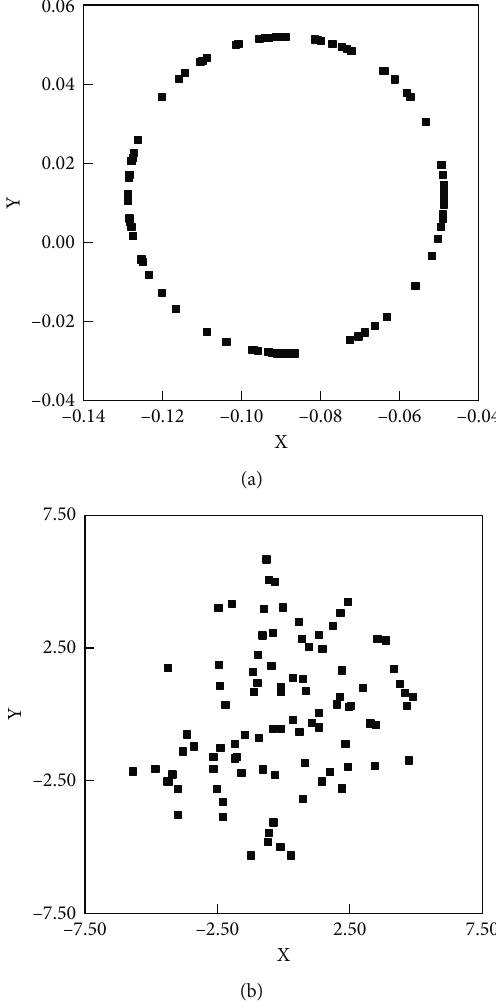
Figure 6: Spatial visualization of single-pilot operation item vectors. (a) Based on the one-hot encoding method. (b) Based on distributed representation